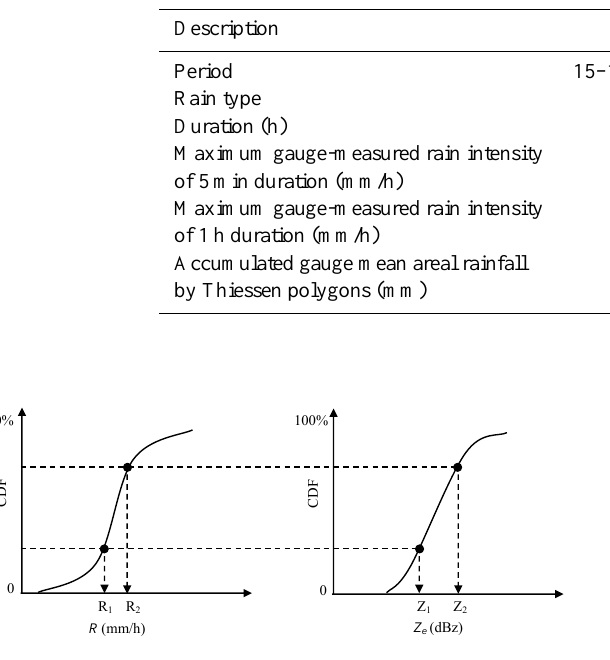
Figure 3. Fig. 3. The probability matching method (PMM).